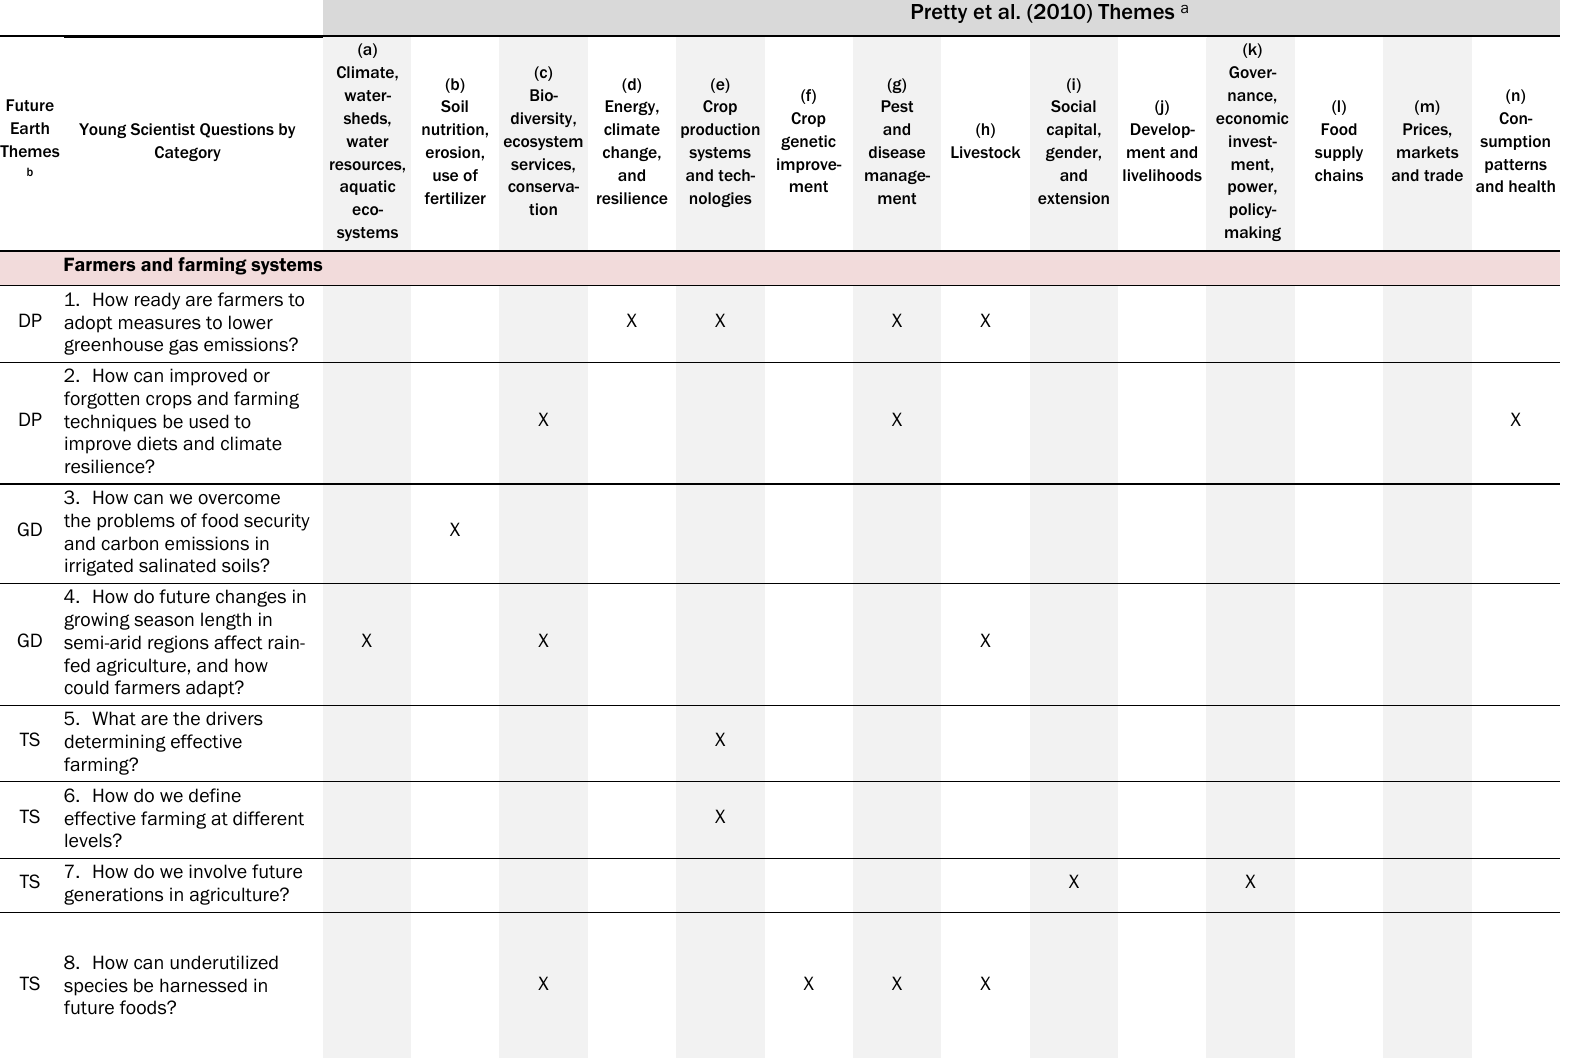
Table 1. Research Questions Identified by the Young Researchers at the Food Futures Conference and Grouped into Categories Compared with the 14 Themes Outlined by the Questions Raised by Pretty et al.